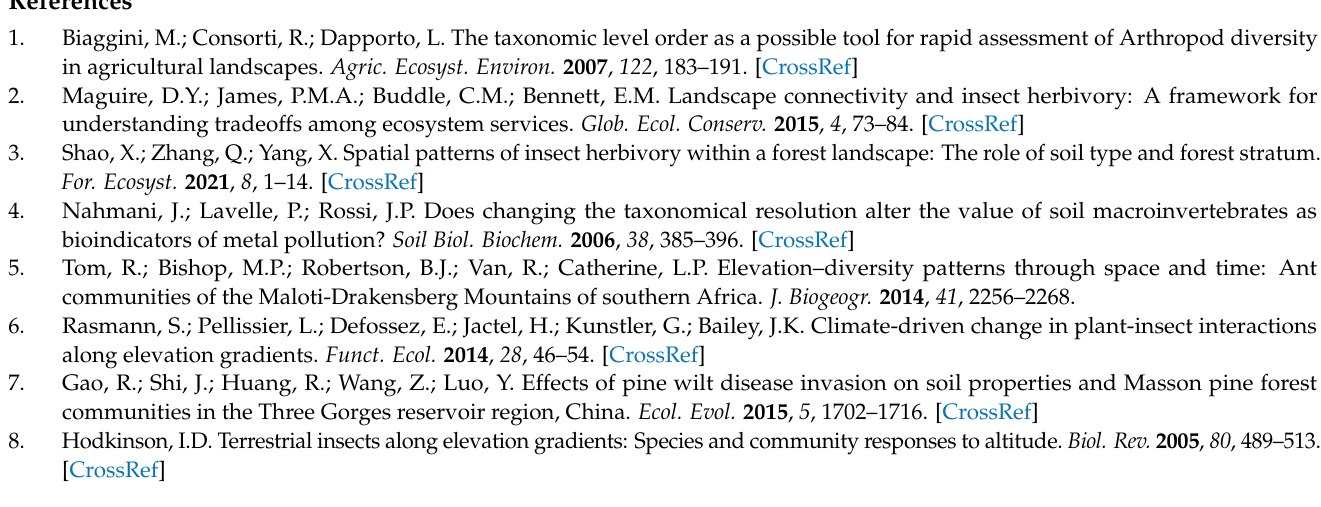
Table S1: The geographical coordinates of seven typical vegetation community ecosystems along the altitude gradient in the Guandi Mountain; Table S2: Analysis of physicochemical properties of 0–10 cm soil layer in typical vegetation community ecosystems along altitudinal gradient of the Guandi Mountain; Table S3: List of the collected insects in the Guandi